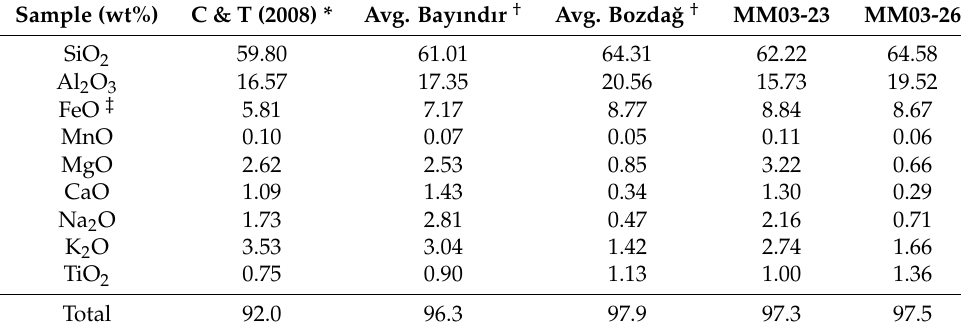
Table 1. Initial bulk rock compositions.